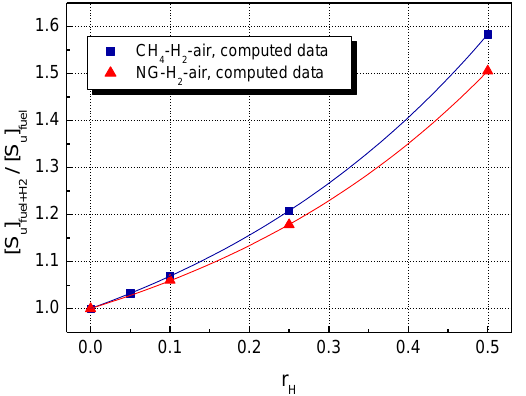
Figure 4. Computed LBV of H 2 -blended CH 4 –air and NG–air with various hydrogen contents at ambient initial conditions.